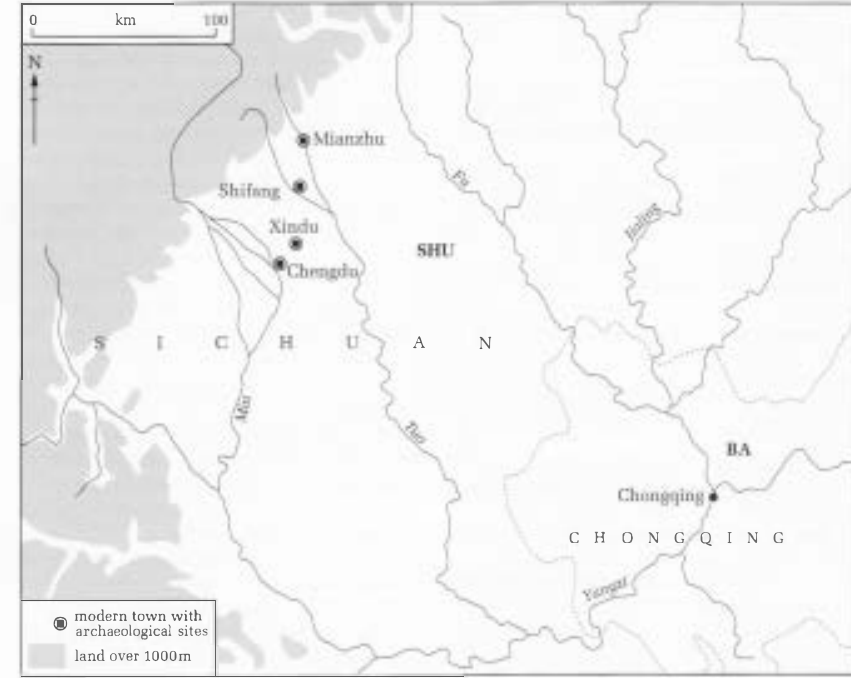
Figure 1 Sichuan province and Chongqing municipality showing the location of the ancient states of Shu and Ba and of the sites mentioned in the